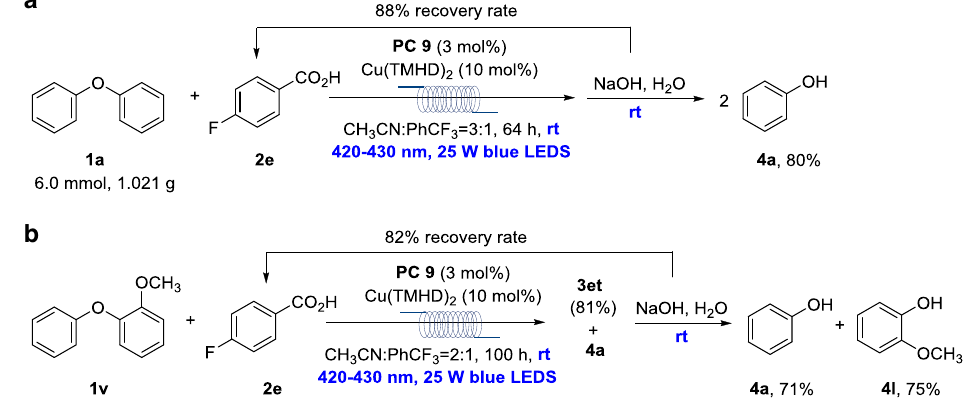
Fig. 5 Gram-scale reaction and its application. a Gram-scale reaction. b Application. Due to the dif fi cult puri fi cation for the isolated yields of 4a and 4l , after the acidolysis, the reaction was worked-up to afford 3et and 4a in 81% and 71% yields,